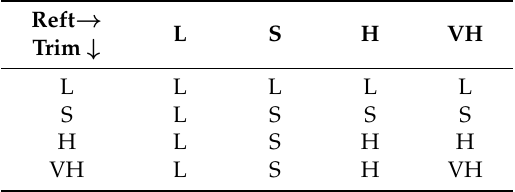
Table 1. Composition of reft and trim producing temp1.